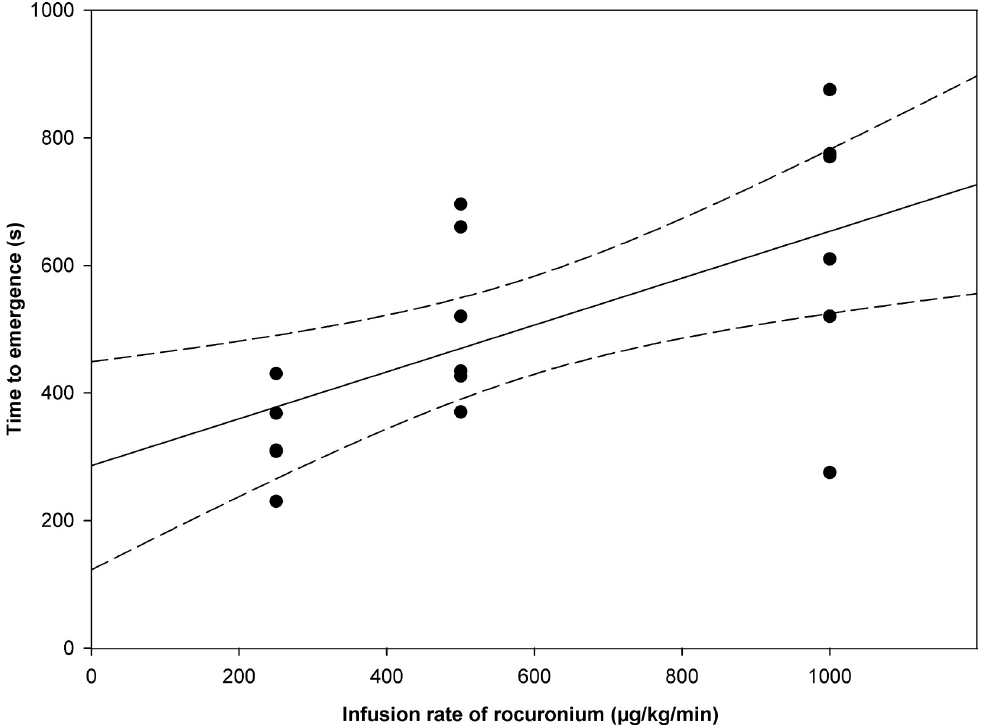
Fig 1. Relation between time to emergence from propofol anesthesia and infusion rate of rocuronium bromide along with propofol using a linear regression model (solid line) with corresponding 95% CIs (dashed lines). Individual responses at each dose (250, 500, 1000 μ g/kg/min) are shown as black circles. The time to emergence from propofol anesthesia was dose-dependently prolonged by simultaneous infusion of rocuronium bromide ( ρ = 0.624, p = 0.006).